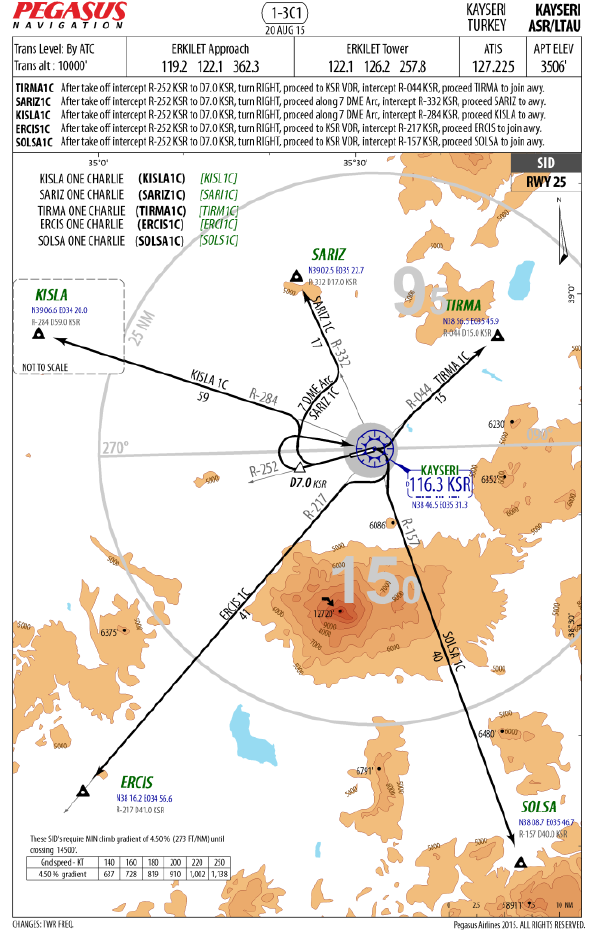
Figure 2. An example of SID